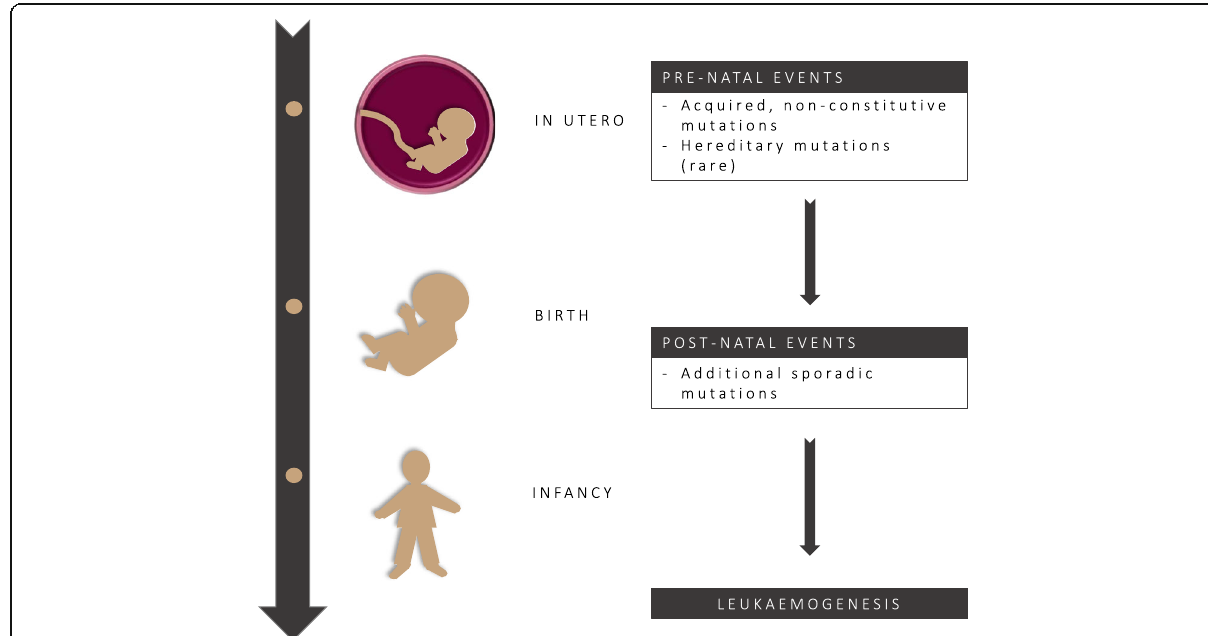
Fig. 5 Multi-hit hypothesis for the insurgence of childhood leukaemia. The initiation of childhood leukaemia requires multiple oncogenic events to occur, with the first event occurring in utero and a second hit occurring after birth or later in life. The first event may be called the predisposing condition at the genomic level that is necessary but not sufficient for the insurgence of cancer. Leukaemia is initiated when a second event promotes abnormal cell proliferation